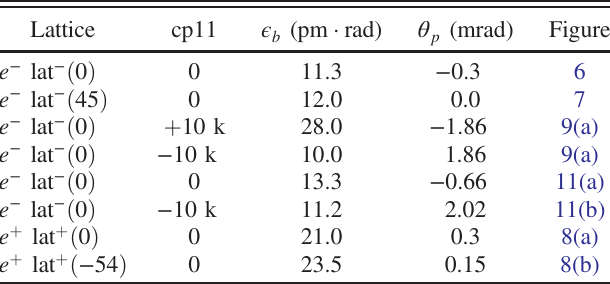
TABLE II. Simulation parameters. Lattice Figure